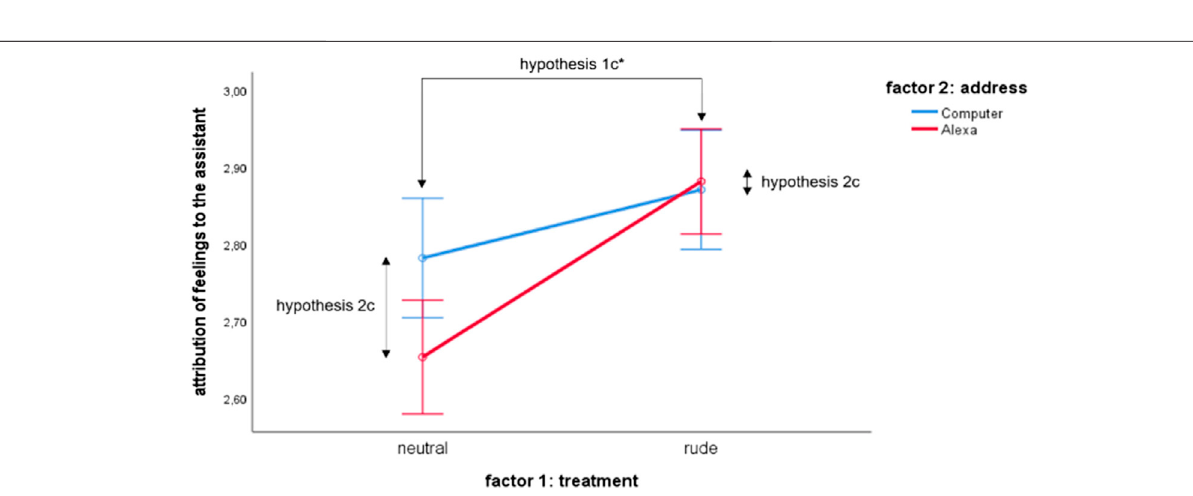
Frontiers in Computer Science |